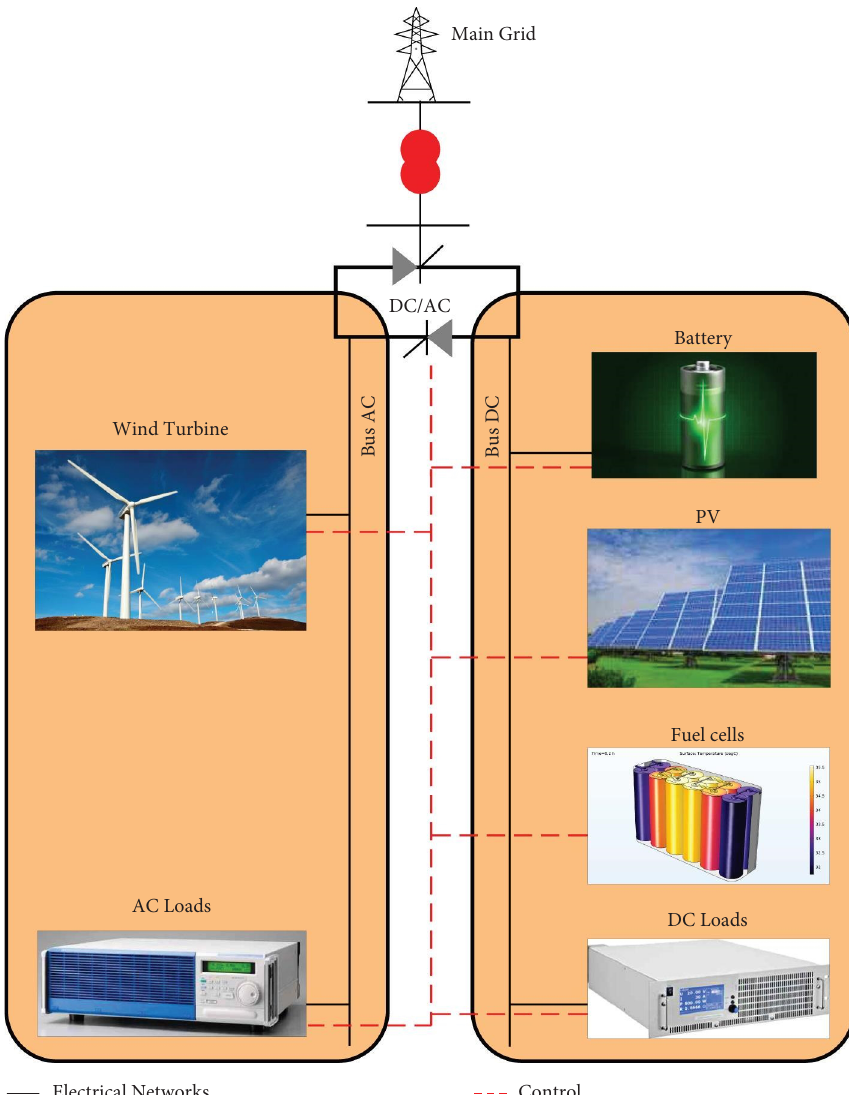
Figure 2: Structure of a hybrid